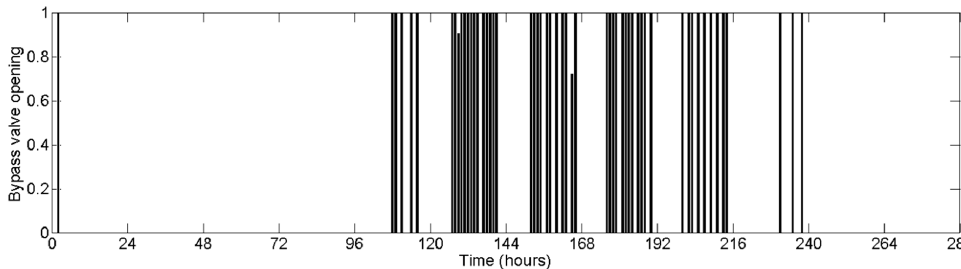
Figure 14. Operational scheduling for the bypass valve of the NC 100–200 turbine installed at location 4.